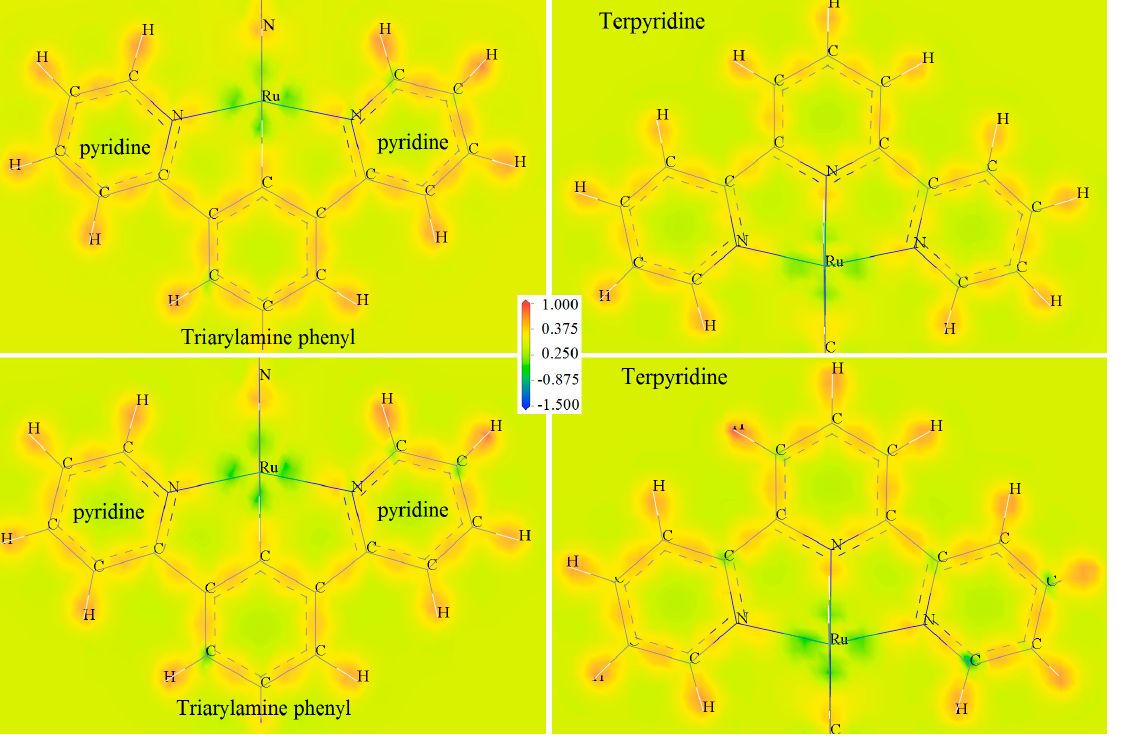
Figure 3. Deformation electron densities contoured on atom planes of triarylamine-phenyl (left panels) and terpyridine (right panels) of CTTC in +3 (top panels) and +6 (bottom panels) redox states. Atomic cores are labeled by element symbols.